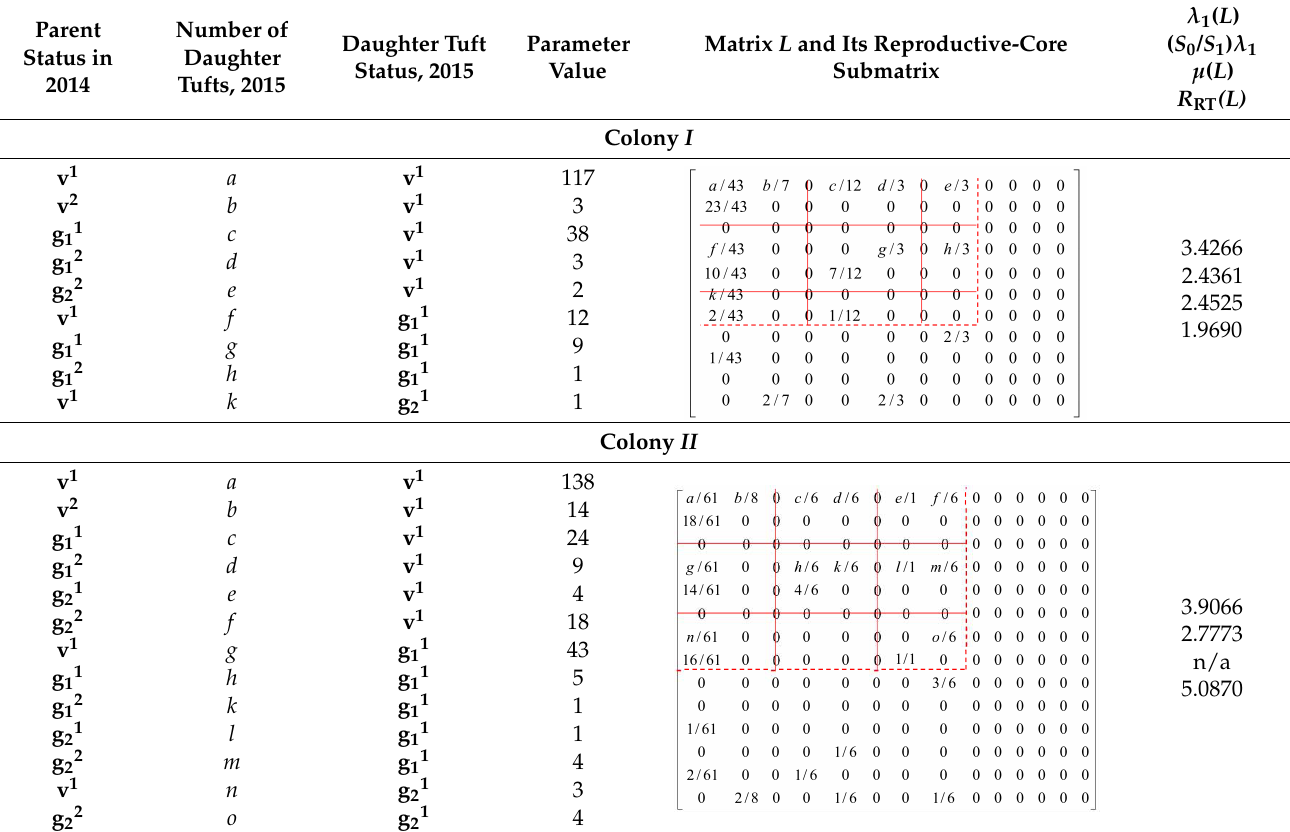
Table 1. Calculation results for the numbers of young sprouted rhizomes (as in Figure 3), the corresponding λ 1 ( L )s *, and the refined adaptation measures µ ( L ) ** (according to Figure